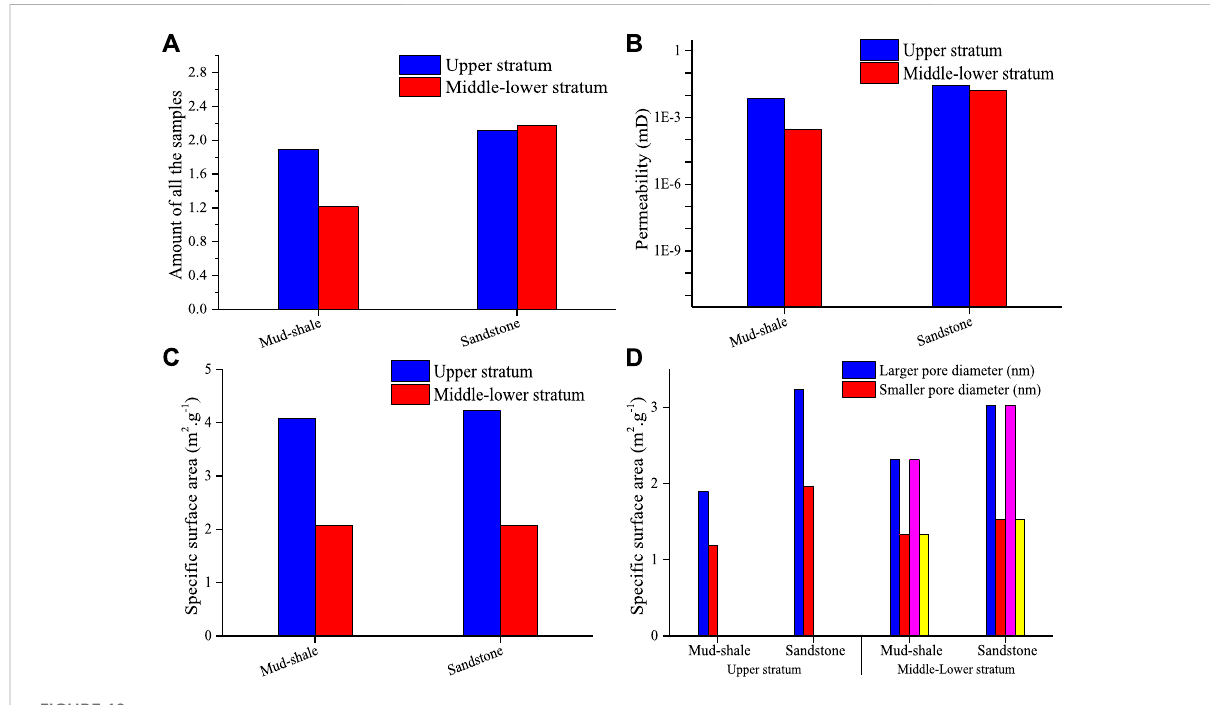
FIGURE 19 Comparison of the petrophysical properties of the upper/middle – lower reservoirs: (A) porosity; (B) permeability; (C) speci fi c surface area; (D) speci fi c surface area comparison of different lithology.